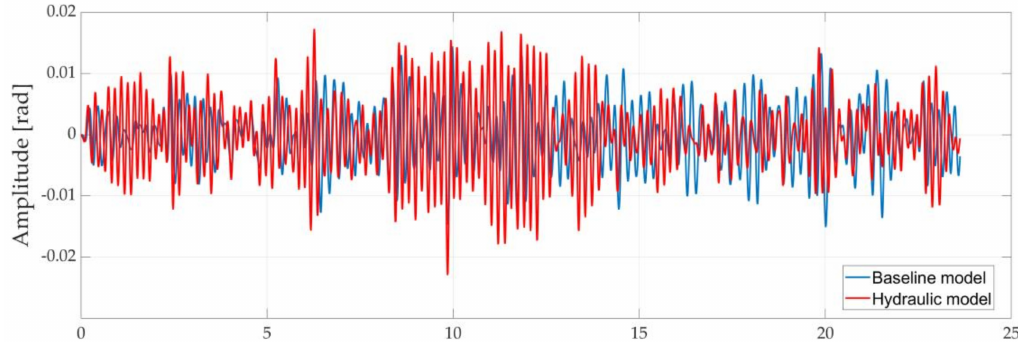
Figure 13. The pitch response to a realistic road